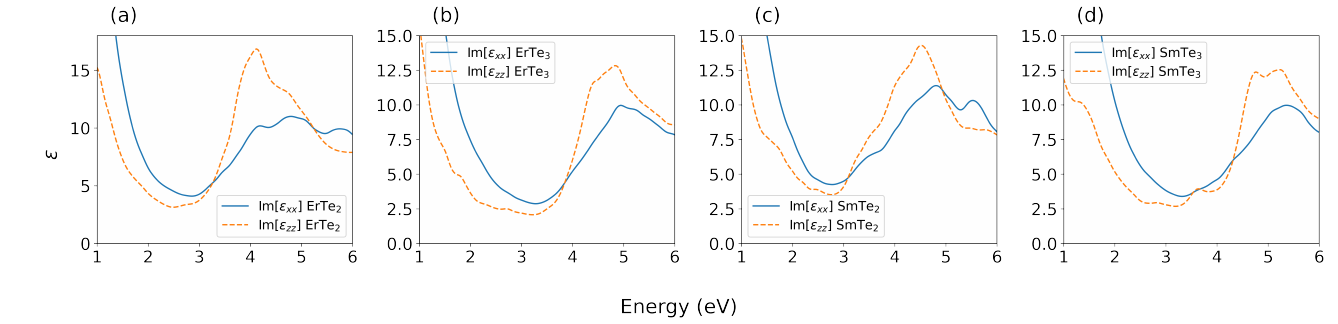
Figure 6. Real parts of the components of the dielectric function parallel ( (cid:101) xx ) and perpendicular ( (cid:101) zz ) to the layers for ( a ) ErTe 2 , ( b ) ErTe 3 , ( c ) SmTe 2 , and ( d ) SmTe 3 .